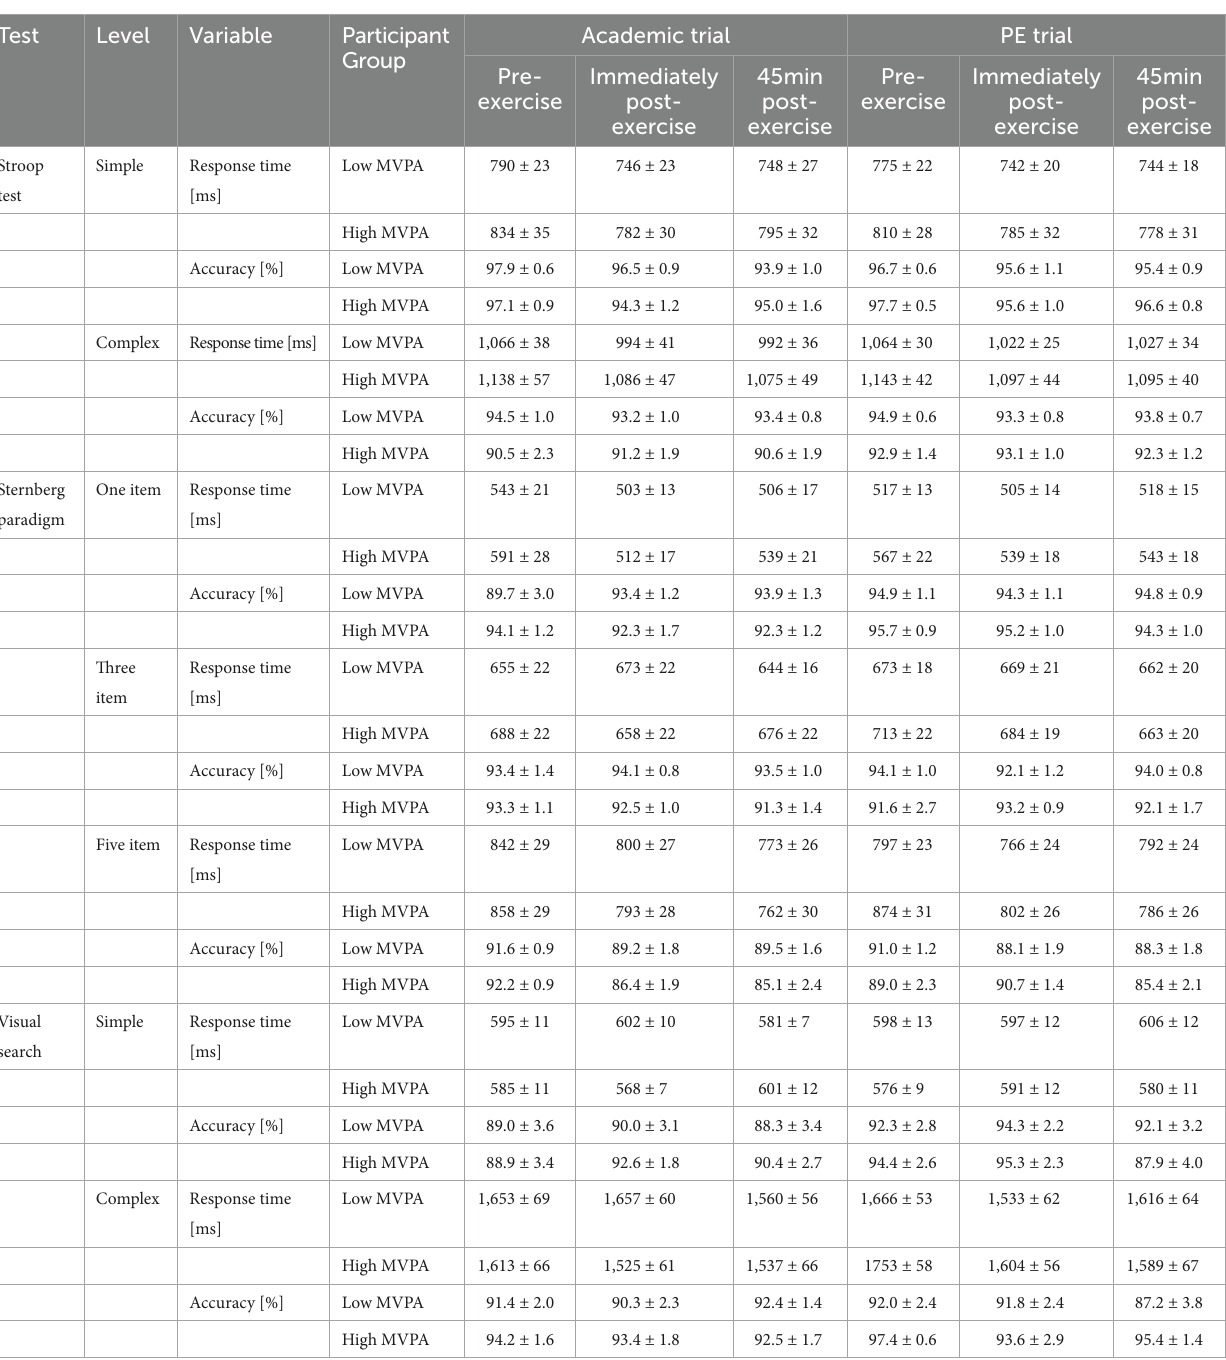
TABLE 5 Cognitive function data across the academic and PE trials for the high and low MVPA